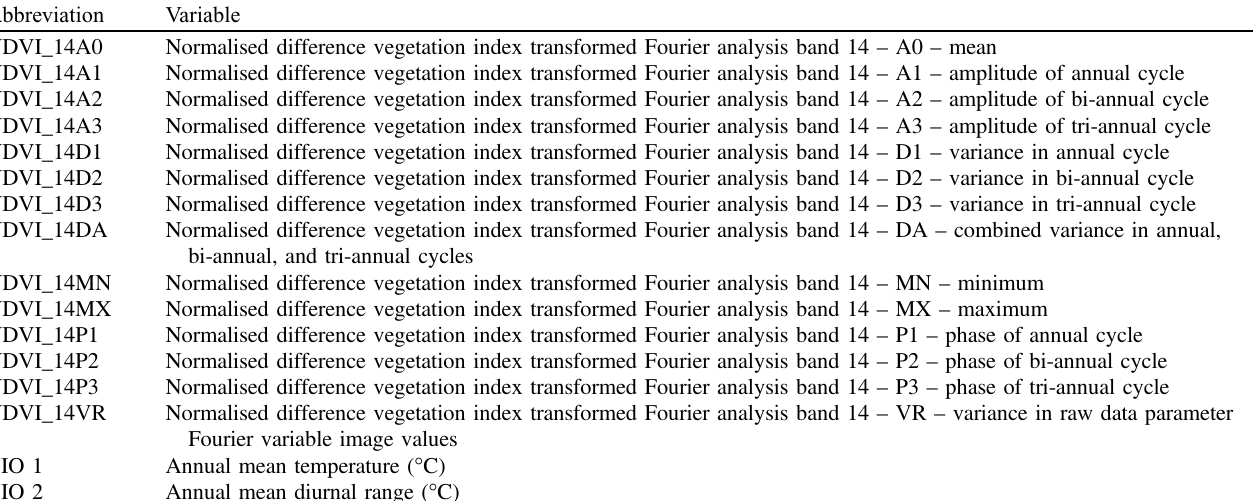
Table 1. Environmental co-variates (predictor